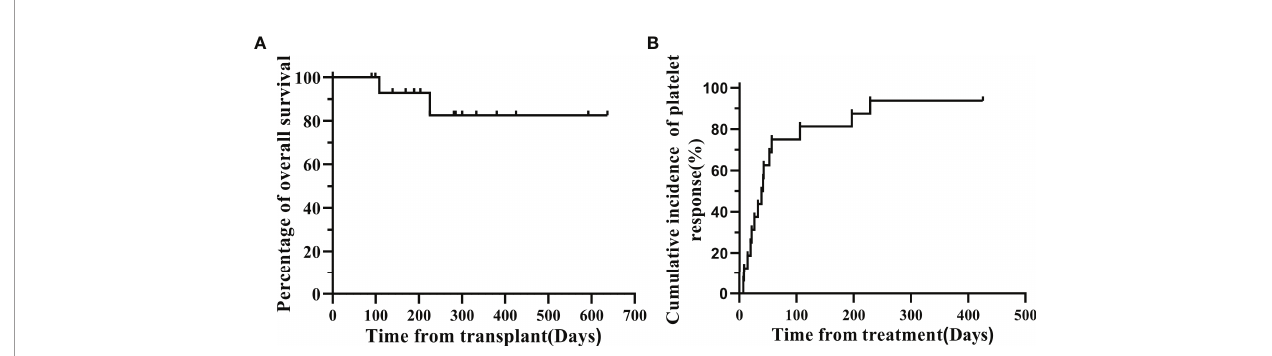
FIGURE 2 | (A) Overall survival probability for the whole cohort. (B) cumulative incidence of platelet response.